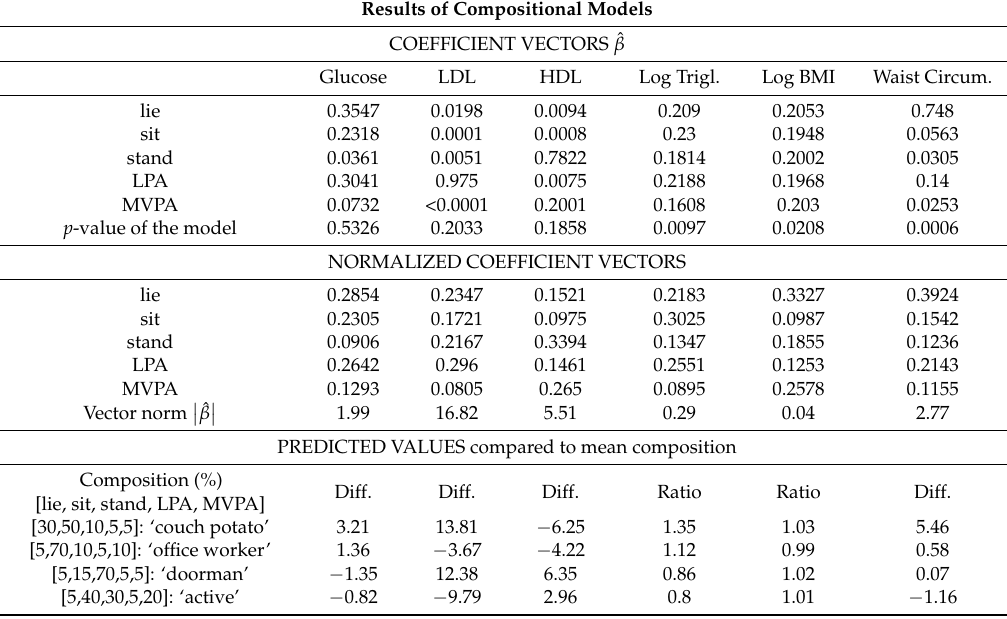
+ < ˆ γ , z > + (cid:101) i i . The middle section of the table shows A (cid:12) (cid:12) (cid:12) ˆ β (cid:12) on ˆ Y . The bottom section of the table show the ˆ Y i . ˆ Y M